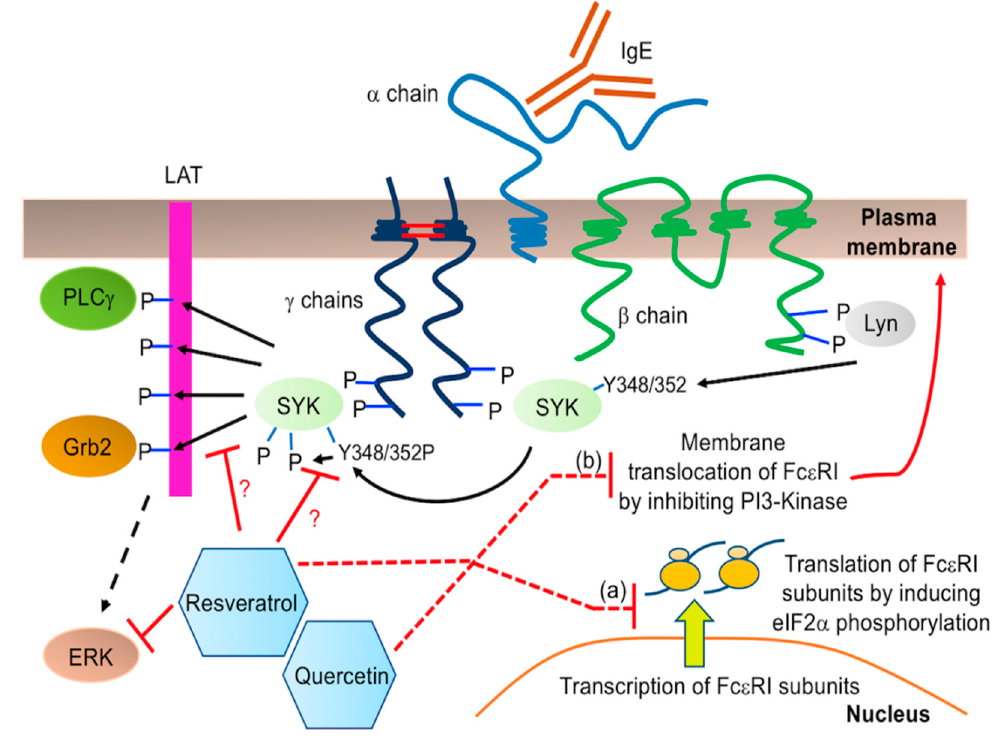
Figure 7. Schematic of Fc ε RI structure and signaling. The receptor is composed of 4 subunits: one α chain, one β chain and two γ chains joined by two disulphide bridges. When activated by IgE cross- linking, Fc ε RI phosphorylates and recruits adaptor proteins Lyn and SYK. Lyn phosphorylation of SYK, especially at tyrosine (Y) residues 348 and 352, and SYK’s autophosphorylation, leads to acti- vation of SYK which then phosphorylates LAT, allowing for recruitment of PLC γ and Grb2. Resveratrol may inhibit this pathway downstream of tyrosine 348 phosphorylation, which is de- tected by the specific anti-phospho-SYK antibody used in this study. It may inhibit SYK autophos- phorylation or phosphorylation of the downstream targets to ultimately prevent ERK phosphory- lation. Some possible mechanisms by which resveratrol and quercetin might inhibit Fc ε RI surface expression include: ( a ) translation of Fc ε RI subunit mRNAs via inducing phosphorylation of eukar- yotic initiation factor 2 α (eIF2 α ) or ( b ) vesicular trafficking of Fc ε RI complex from endoplasmic re- ticulum to the plasma membrane via inhibiting phosphoinositide 3-kinase (PI3-Kinase). SYK and ERK signaling pathways play an important role in orchestrating Fc ε RI- me- diated MC signal transduction, leading to mediator release. Interestingly, our data sug- gests that quercetin and resveratrol did not alter SYK and ERK phosphorylation and degranulation by BMMC activated through Fc ε RI despite lower cell surface expression of Fc ε RI. There are several possibilities for this novel observation. First, our Western blot analysis measured phosphorylation of these proteins only after 5 min of stimulation of the Fc ε RI. Since membrane-proximal phosphorylation of SYK is very rapid, it is possible that the time at which these compounds modify SYK phosphorylation is earlier than 5 min. Second, it is possible that the threshold for Fc ε RI expression to significantly impact SYK phosphorylation has not been reached with quercetin or resveratrol and the cell is still capable of a robust SYK response despite the change in Fc ε RI expression. Third, in several experiments, including those looking at SYK/ERK phosphorylation and degranulation in BMMC, cells were simultaneously treated with resveratrol/quercetin and IgE. In other ex- periments, including those looking at Fc ε RI expression by flow cytometry, TNF release in BMMC and degranulation in LAD2, cells were exposed to quercetin and resveratrol